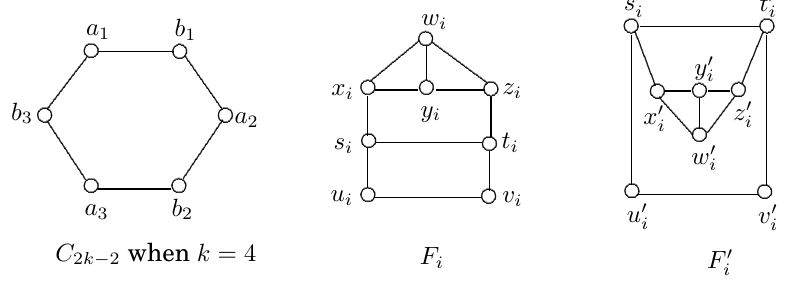
Figure 2: Three plane graphs.